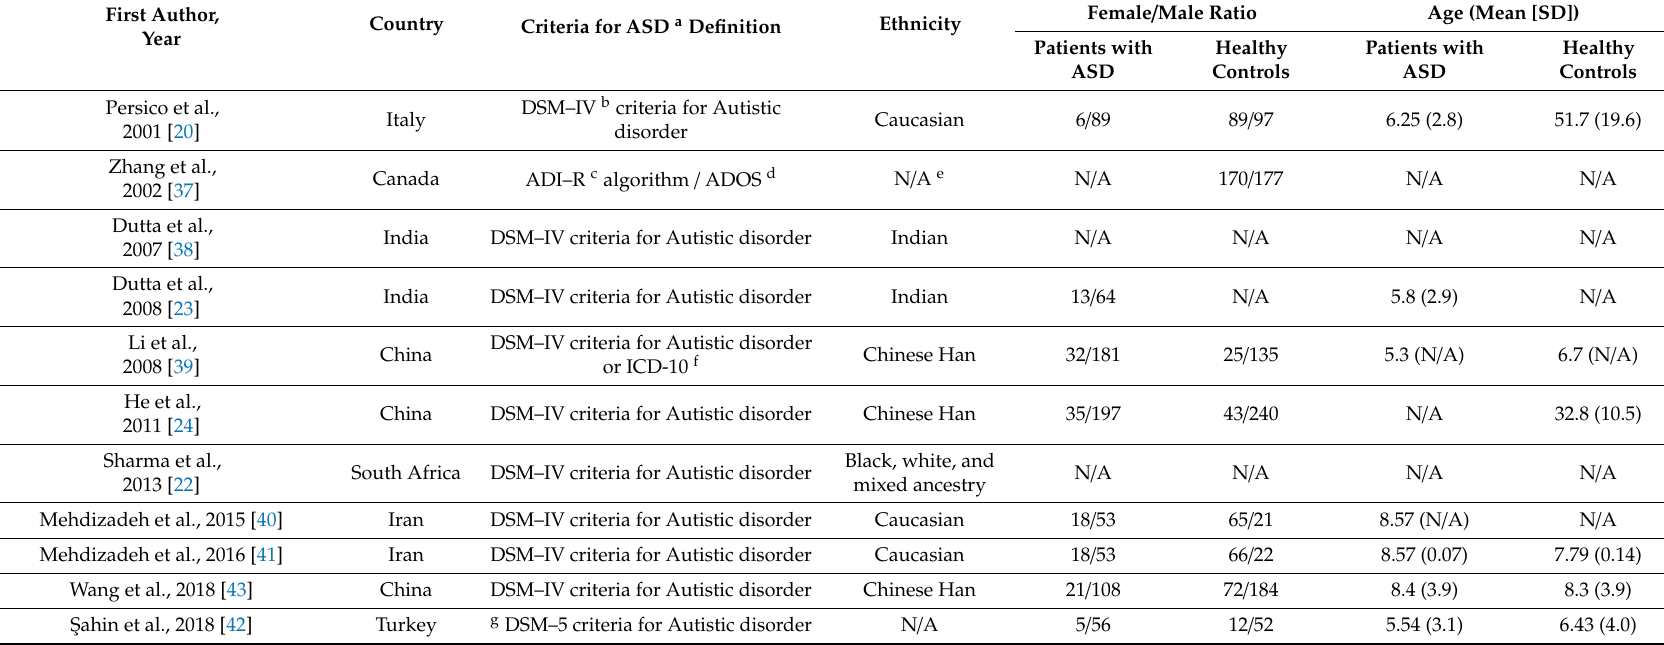
Table 4. Characteristics of the studies included in the